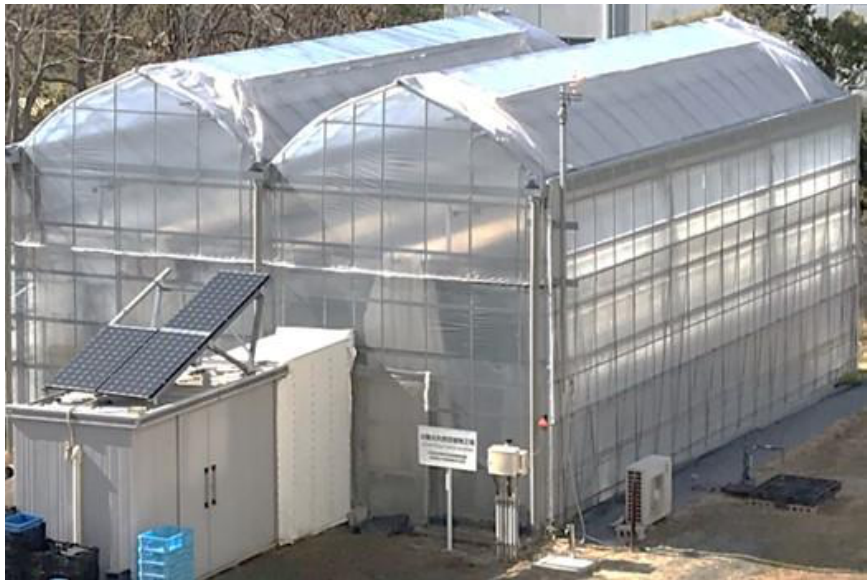
Figure 3. The greenhouse for CO 2 measurement.